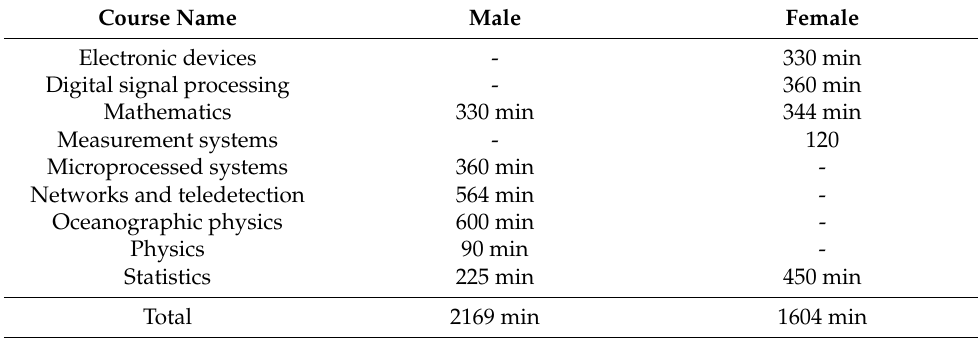
Table 1. Breakdown of the dataset by minutes per course and per